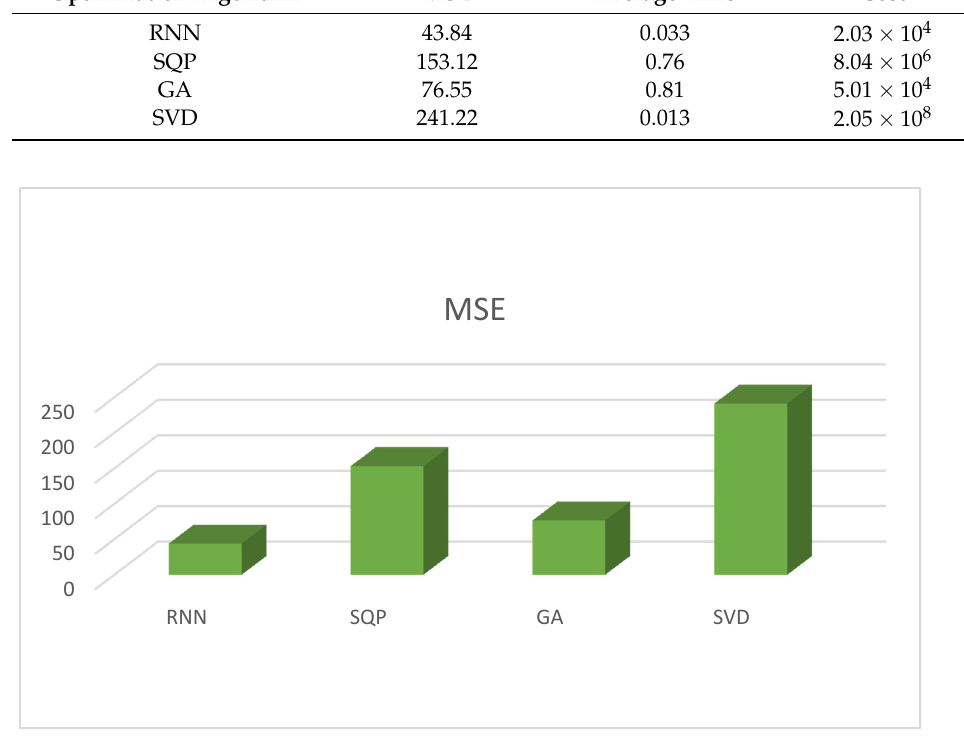
Figure 8. Average run-time of different optimization algorithms.